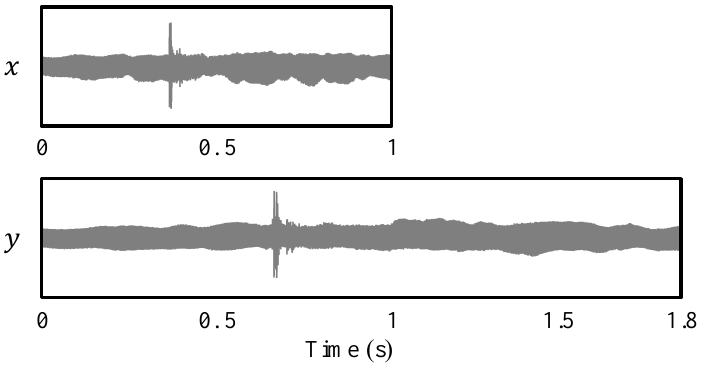
Figure 12. Transient preservation in TSM based on harmonic-percussive separation (HPS). The input signal x is the same as in Figure 10 and is stretched by a factor of α = 1.8 using TSM based on